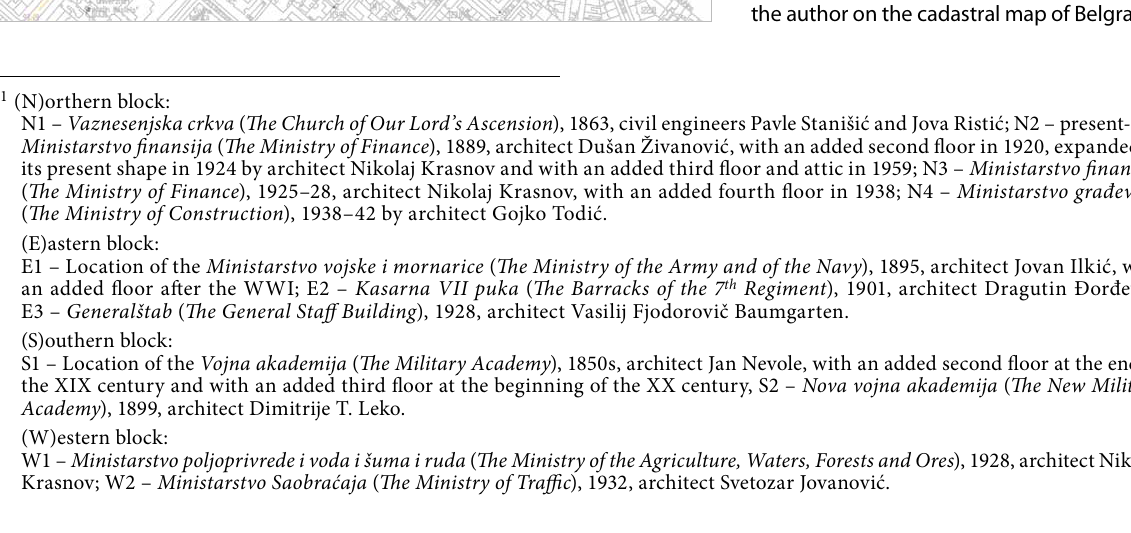
fig. 2. Closer layout of the intersection with the disposition of main buildings in blocks and their function at the time of construc- tion 21 . Buildings a and B are marked as E1 and S1, respectively. Source : interventions of the author on the cadastral map of